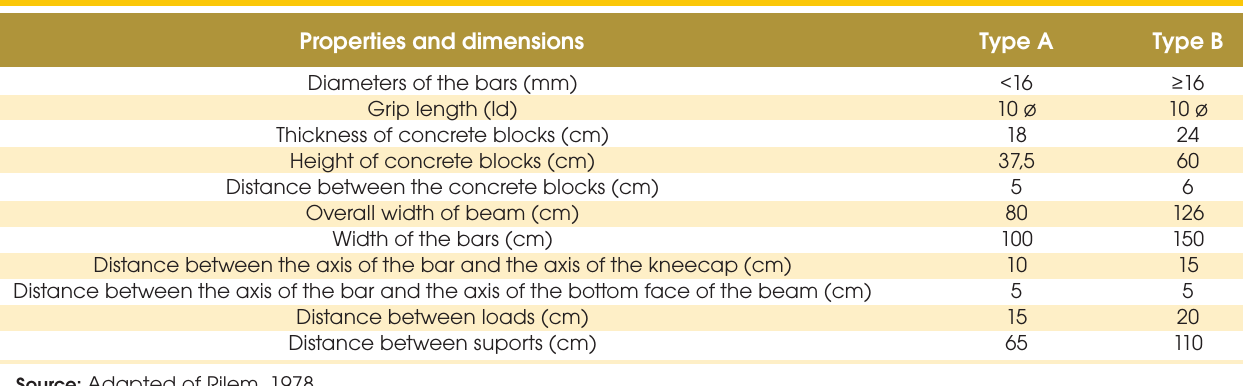
Table 2 – Parameters for verifying adherence between the concrete and steel bars Properties and